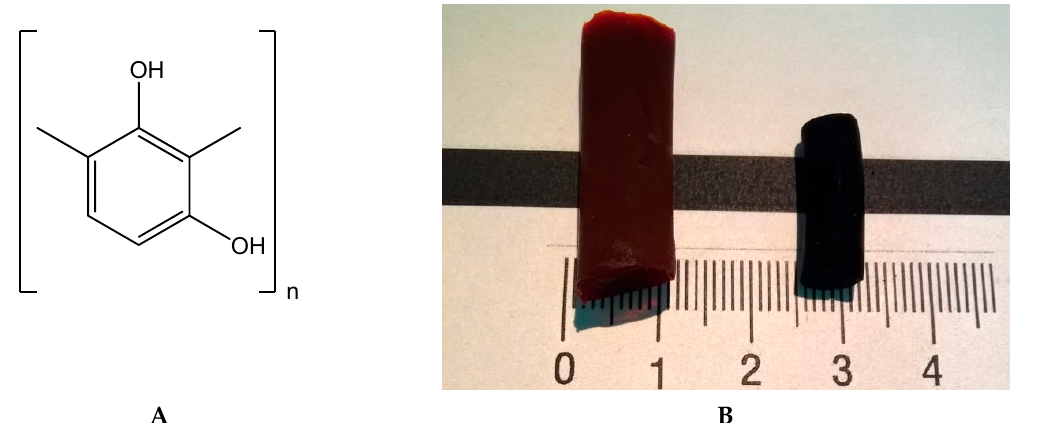
Figure 1. Resorcinol-formaldehyde (RF)-gel and aerogel chemical structure ( A ). RF-(left) and carbon aerogel (C-AGs) (right) ( B ). After cooling and washing with isopropanol all “wet” samples were dried in supercritical CO 2 at 50 °C/150 atm. As a result dark-brown semitransparent RF-aerogels were obtained (Figure 1 B , left). The pyrolysis of these samples was carried out in an atmosphere of nitrogen in the temperature range 700–1100 °C and resulted in C-AGs (Figure 1 B , right). Hereafter the following notation is used: C-AGs prepared from RF-AGs at 700 °C are denoted RF-700, etc. C-AG linear size was approximately one and a half time smaller than that of parent RF-AGs (Figure 1 B ).